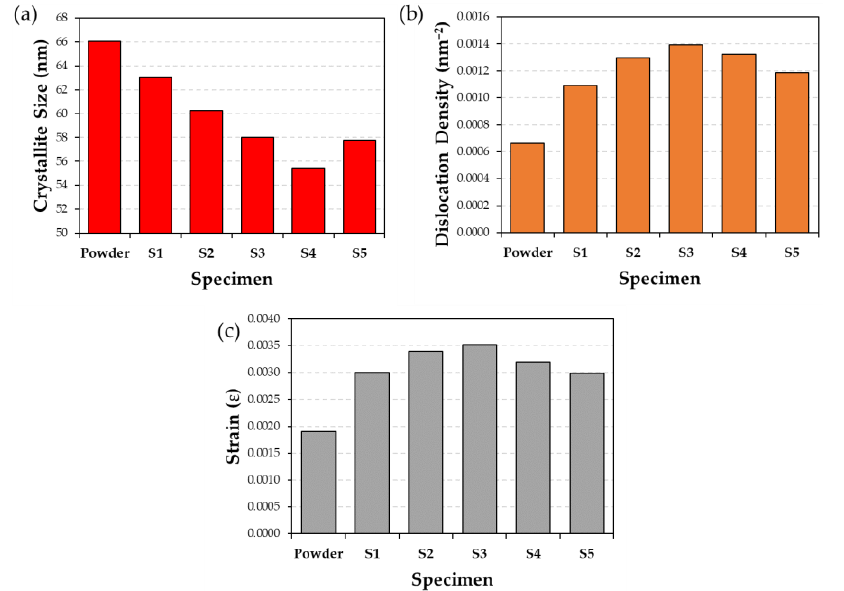
Figure 10. The Williamson-Hall plots for ( a ) the CS Zr powder and CS Zr coatings ( b ) S1, ( c ) S2, ( d ) S3, ( e ) S4, and ( f ) S5.